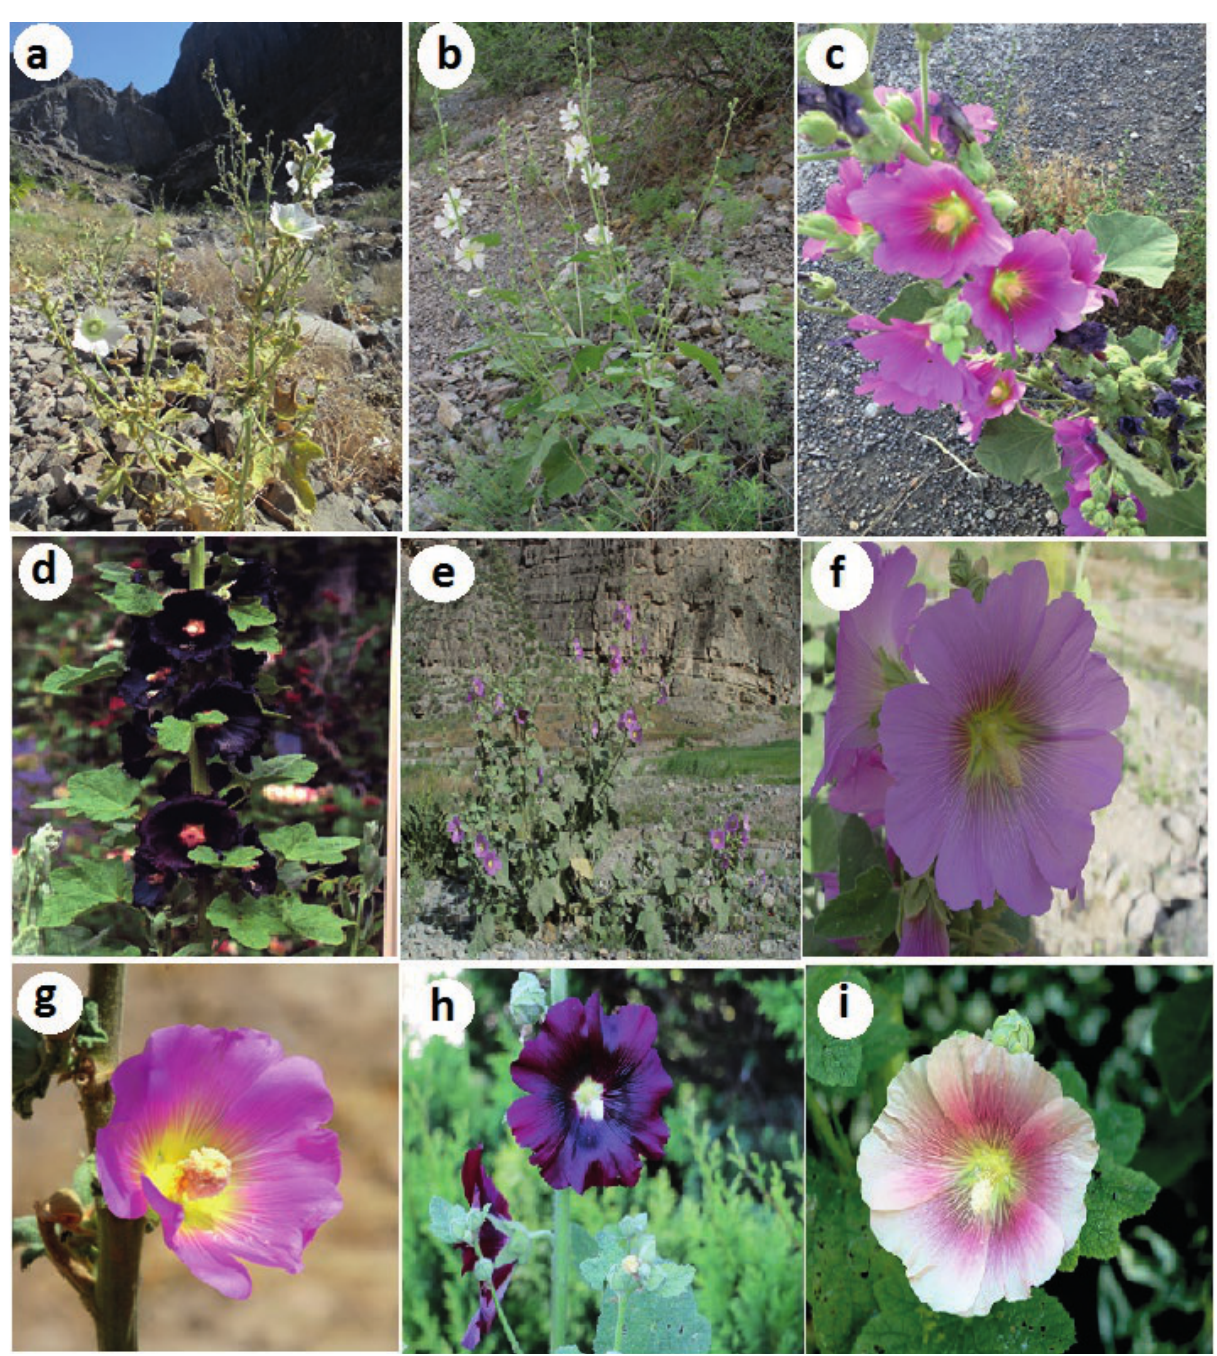
Figure 1. Alcea species:a, i: A. flavovirens ; b: A. sachsachanica ; c: A. rechingeri ;d, h: A. arbelensis ; e: A. koelzii ; f, g: A.